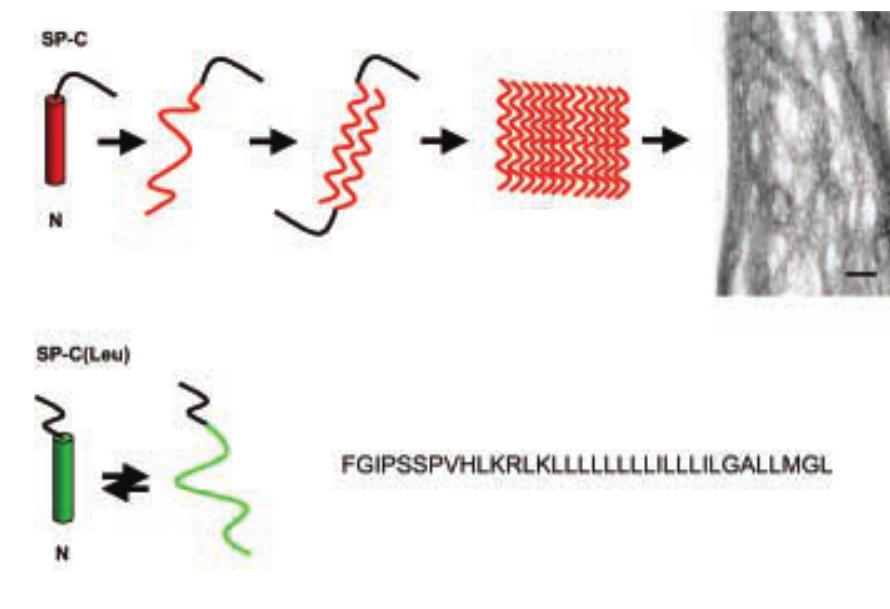
Folding and aggregation of SP-C and SP- C(Leu). Schematic representation of the differ- ent behaviour of SP-C compared to SP-C(Leu) regarding folding and aggregation, as derived from hydrogen/deuterium exchange in combi- nation with NMR and mass spectrometry. Both peptides are helical in their native states (N). SP-C(Leu) (green) refolds into a helix after un- folding, while SP-C (red) forms b -sheet aggre- gates and amyloid fibrils after unfolding, with no detectable refolding of helical structure. The amino acid sequence of SP-C(Leu) is shown, see figure 2 for the amino acid sequence of